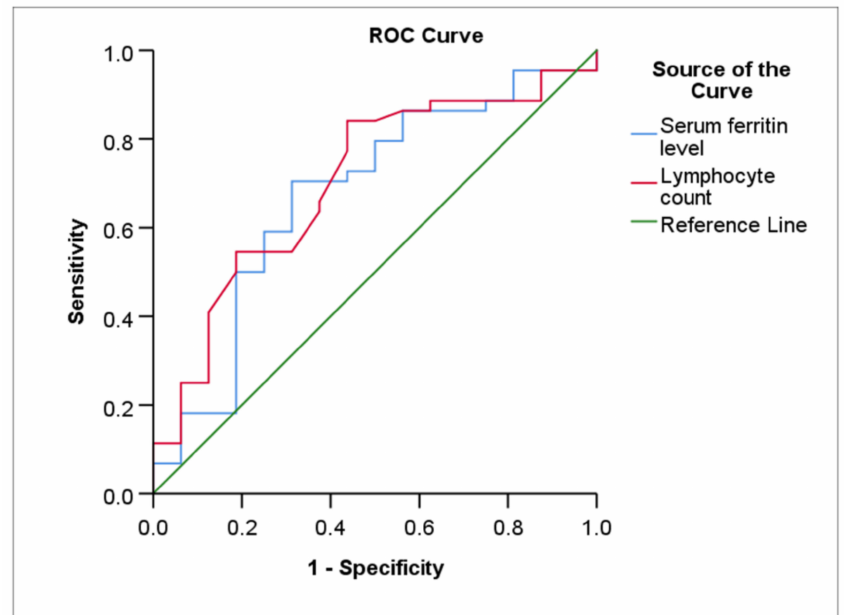
Figure 3. The ROC curves of serum ferritin level and lymphocyte count for prediction of NIV failure. NIV: non-invasive ventilation; ROC: Receiver operator